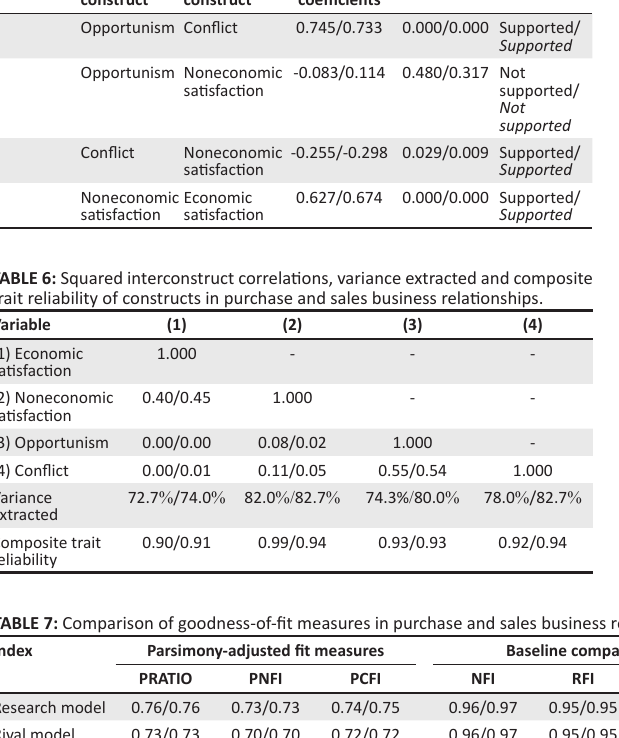
TABLE 5: Regression coefficients and significances in purchase and sales business relationships. Hypothesis Exogenous